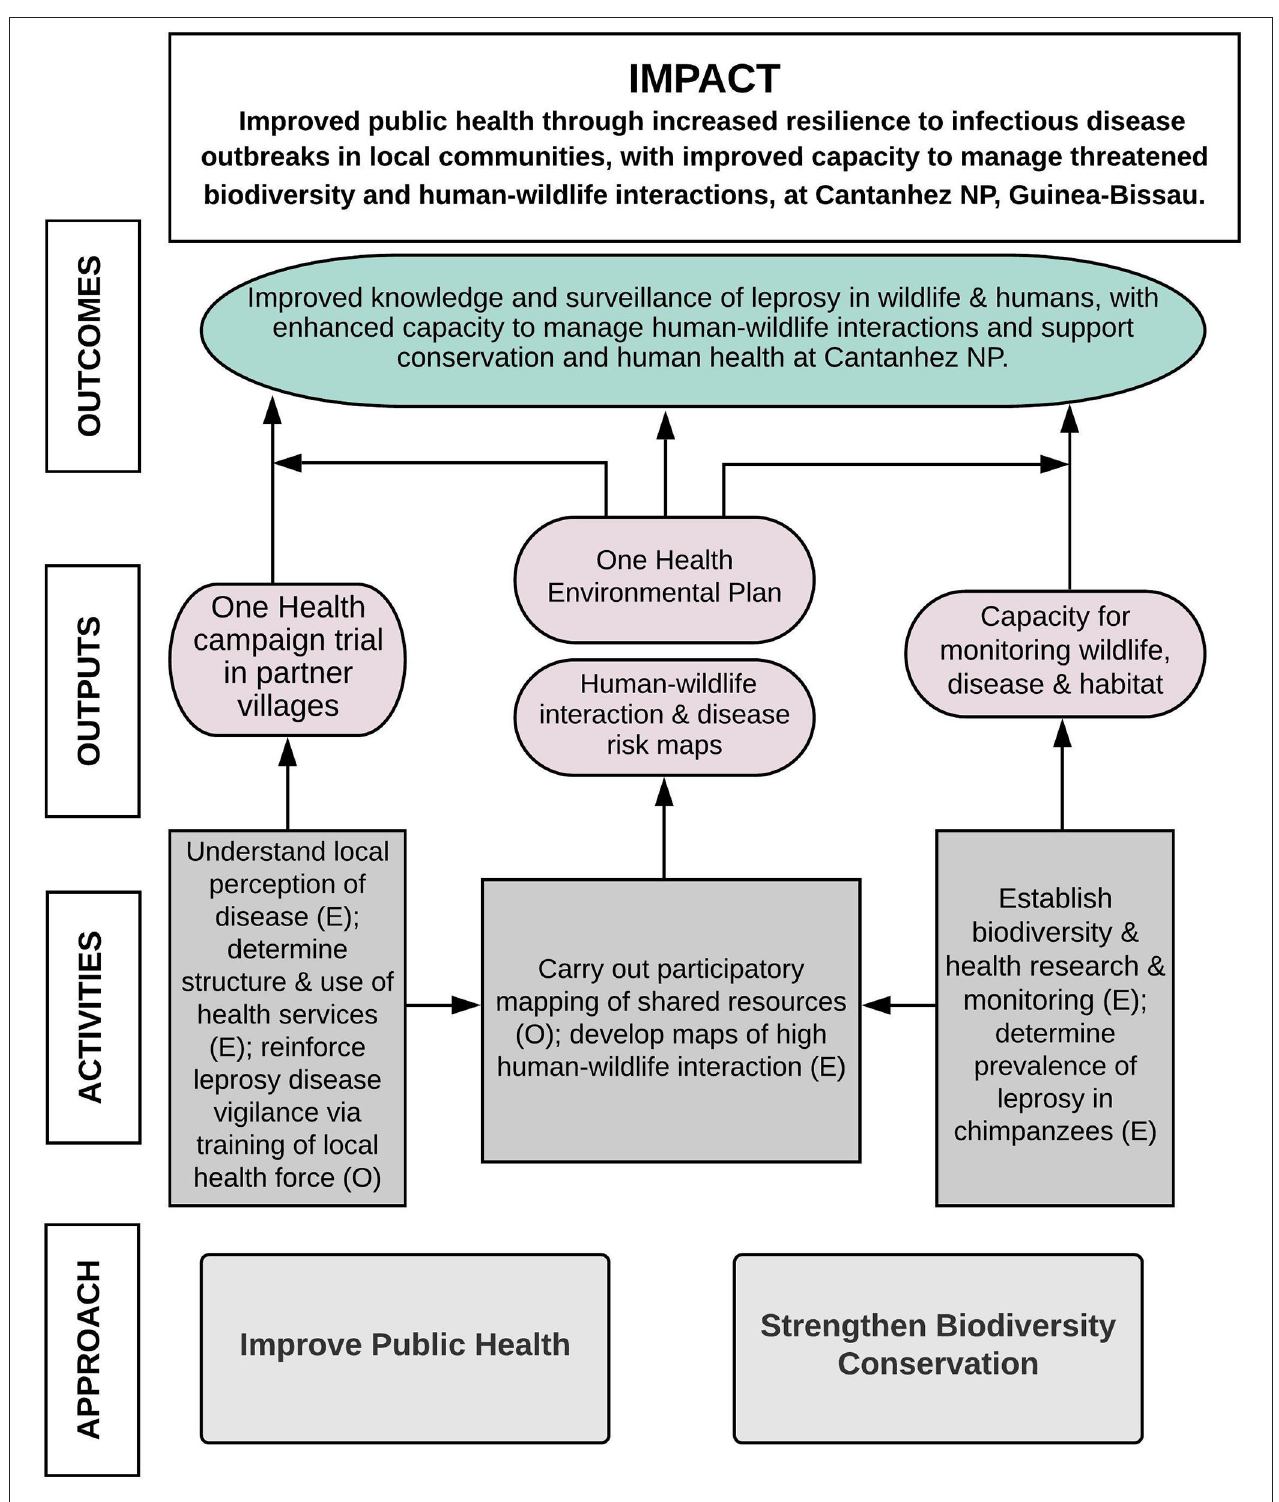
FIGURE 2 | A theory of change model including the project’s: Impact —higher level objective that the project will help towards achieving; Outcomes —changes expected from the project and who is expected to benefit; Outputs —specific, direct deliverables of the project; and Activities —main tasks that the project will carry out. (E) represents executed activities and (O) shows ongoing activities. Our project Measurable Indicators include: (Outcome) By end of project, institutional capacity